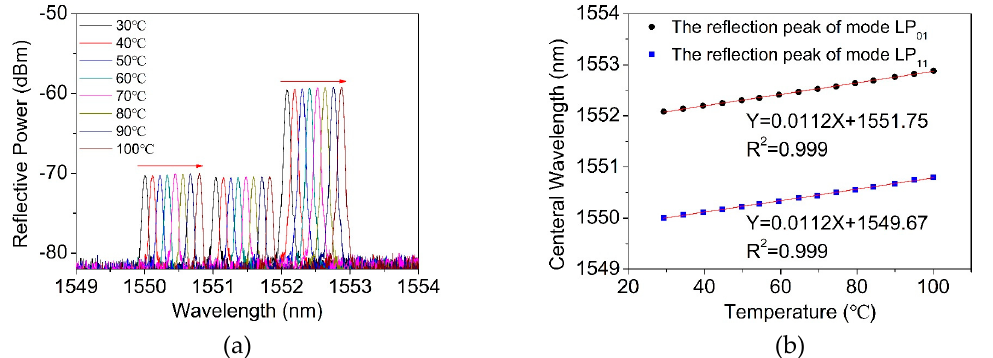
Figure 6. Schematic diagram of the two-mode FBG temperature experiment.